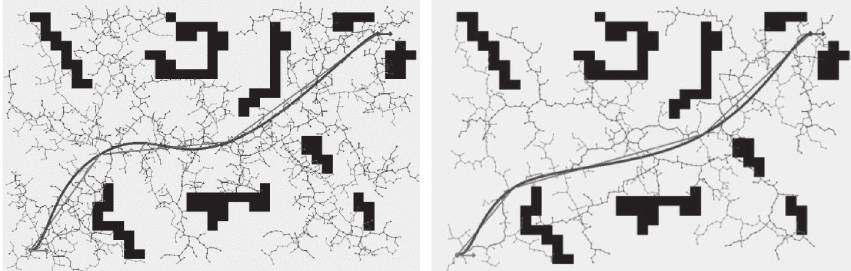
Figure 11: Schematic diagram of algorithm (a) before and (b) after